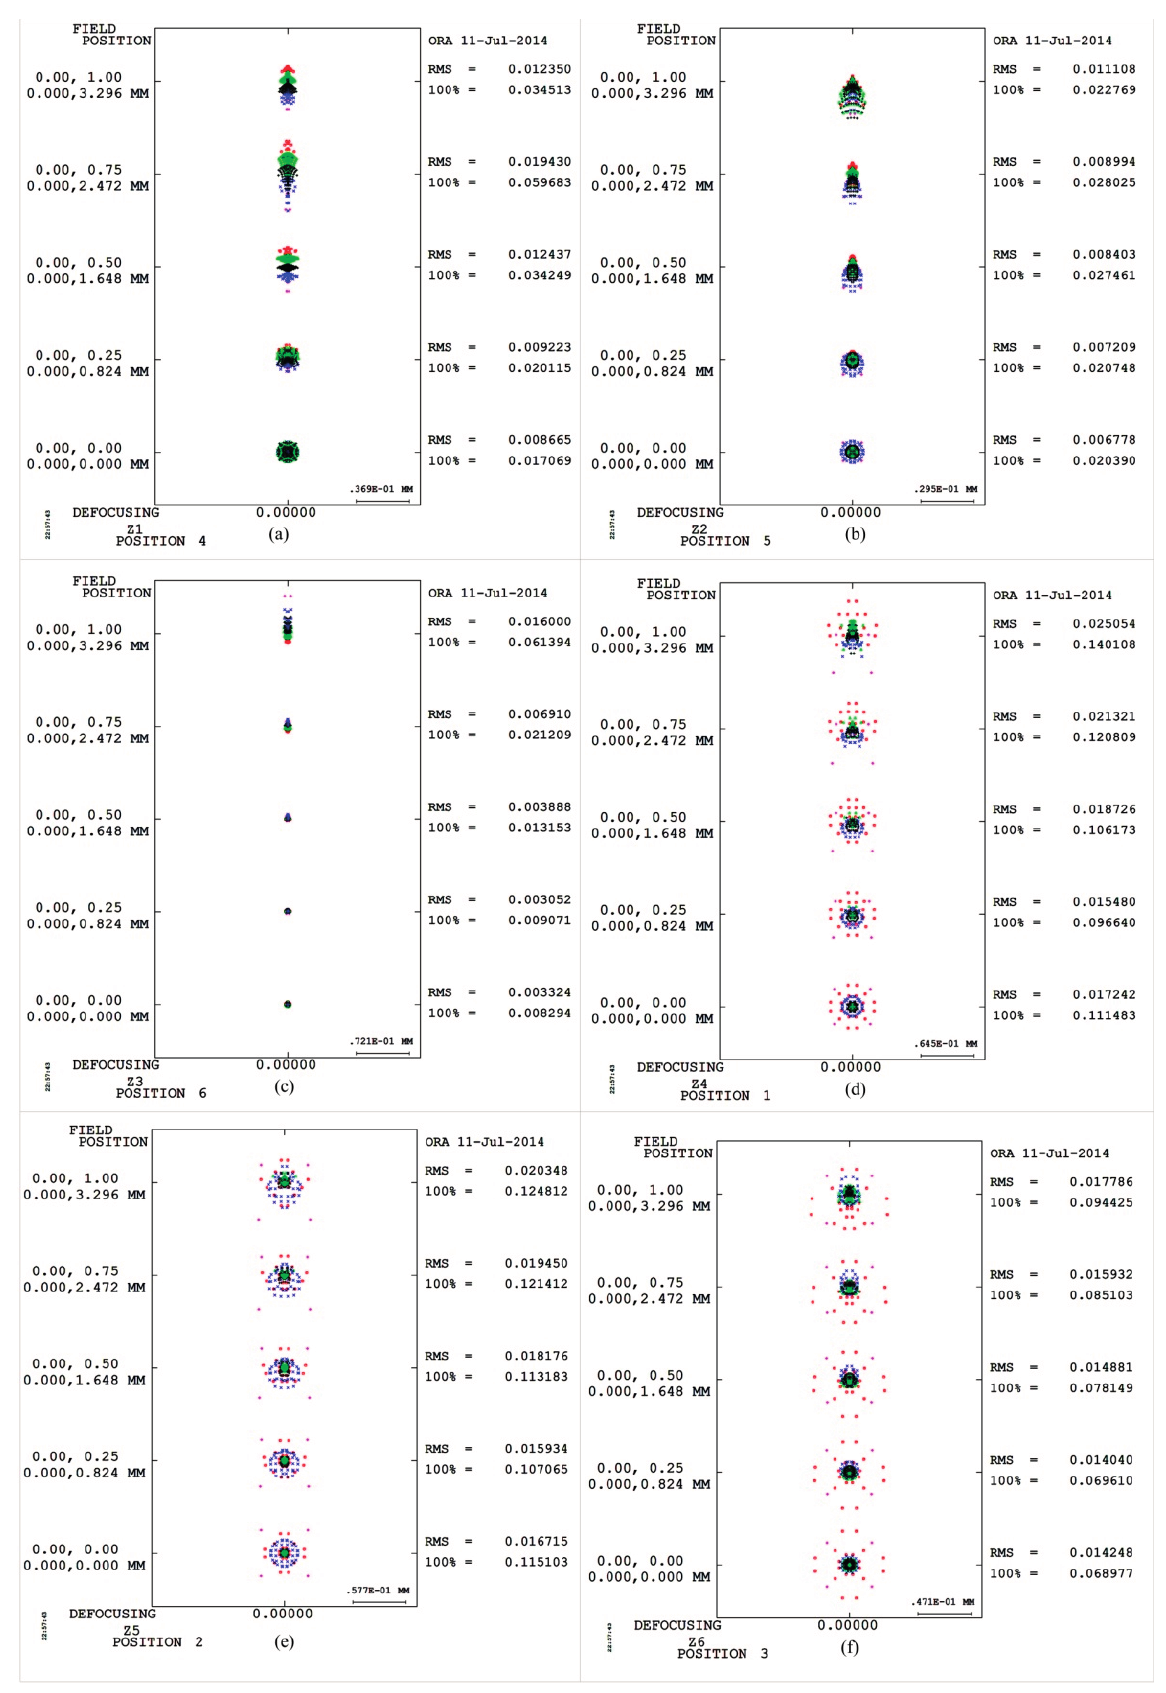
Figure 11. Spot plots of the proposed lens: ( a ) Zoom 1; ( b ) Zoom 2; ( c ) Zoom 3; ( d ) Zoom 4; ( e ) Zoom 5; ( f ) Zoom